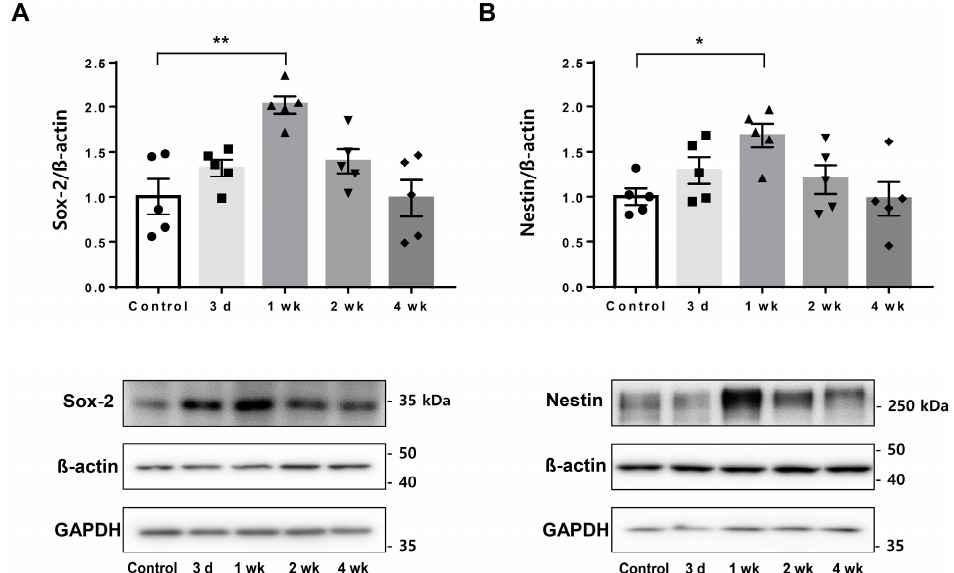
Figure 2. Comparison of eNSC markers by using LIFUS. ( A ) Western blotting for Sox-2 comparing the control and LIFUS groups. ( B ) Western blotting for nestin comparing the control and LIFUS groups. Data are expressed as the mean ± standard error of the mean. n = 5 for each group. * p < 0.05, ** p < 0.01; one-way ANOVA with Tukey’s post hoc comparisons was used to analyze the data. eNSC, endogenous neural stem cell.